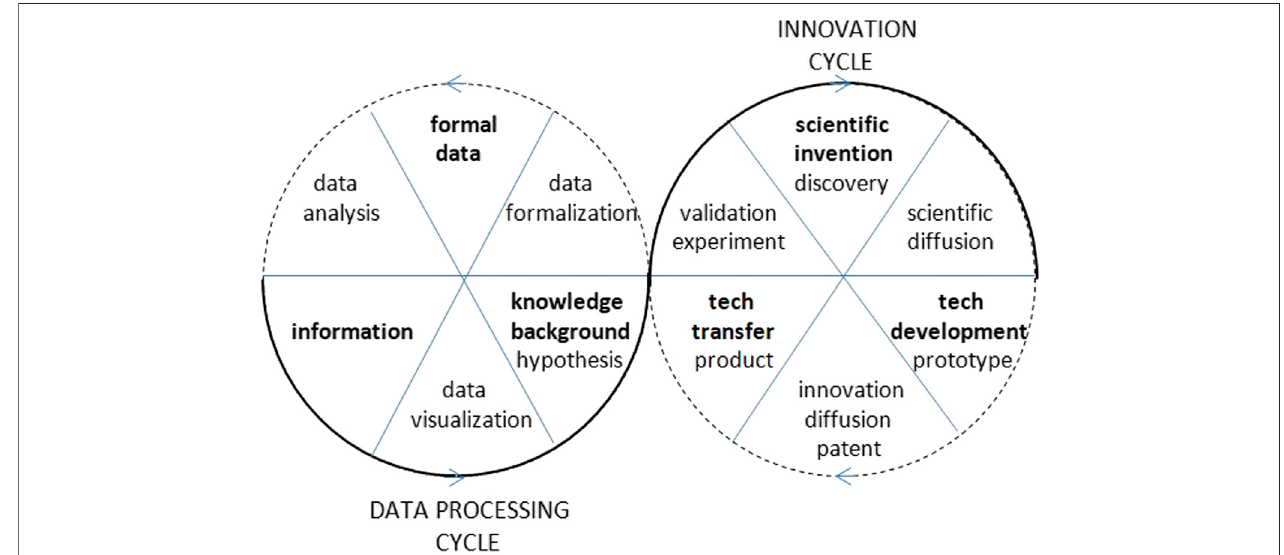
FIGURE 8 | Representation of the sequentiality of data processing and innovation